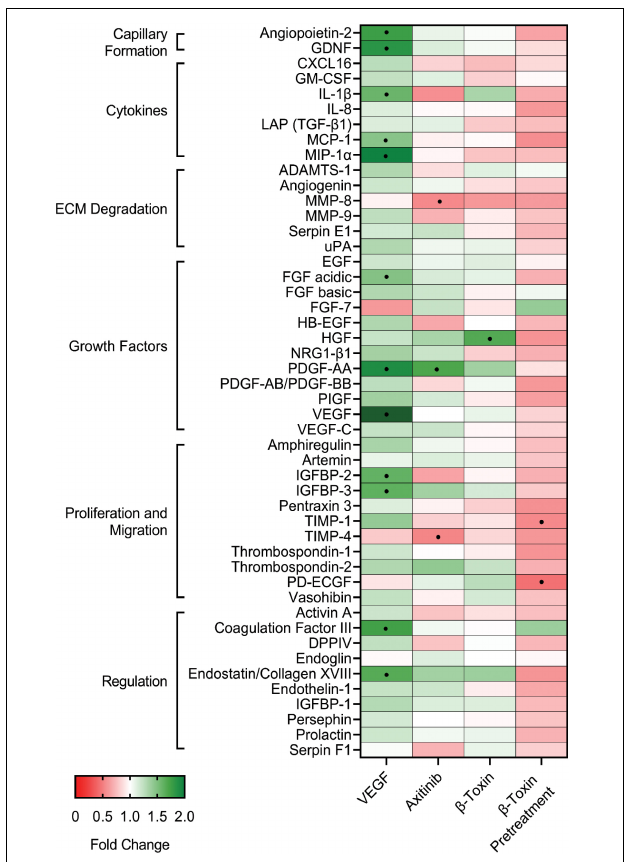
FIGURE 3 | β -toxin modulates production of angiogenic proteins from iHAECs during wound healing. iHAECs grown to confluency in silicone inserts that create uniform gaps upon removal and treated with either VEGF (10 ng mL − 1 ), axitinib (10 µ M), or β -toxin (50 µ g mL − 1 ) for 24 h. Angiogenesis proteome arrays were determined from culture supernatants collected at 24 h. Results shown are the mean fold change from untreated cells of five independent experiments. Angiogenic-related factors with a 50% increase ( > 1.5-fold change) or decrease ( < 0.5-fold change) from media